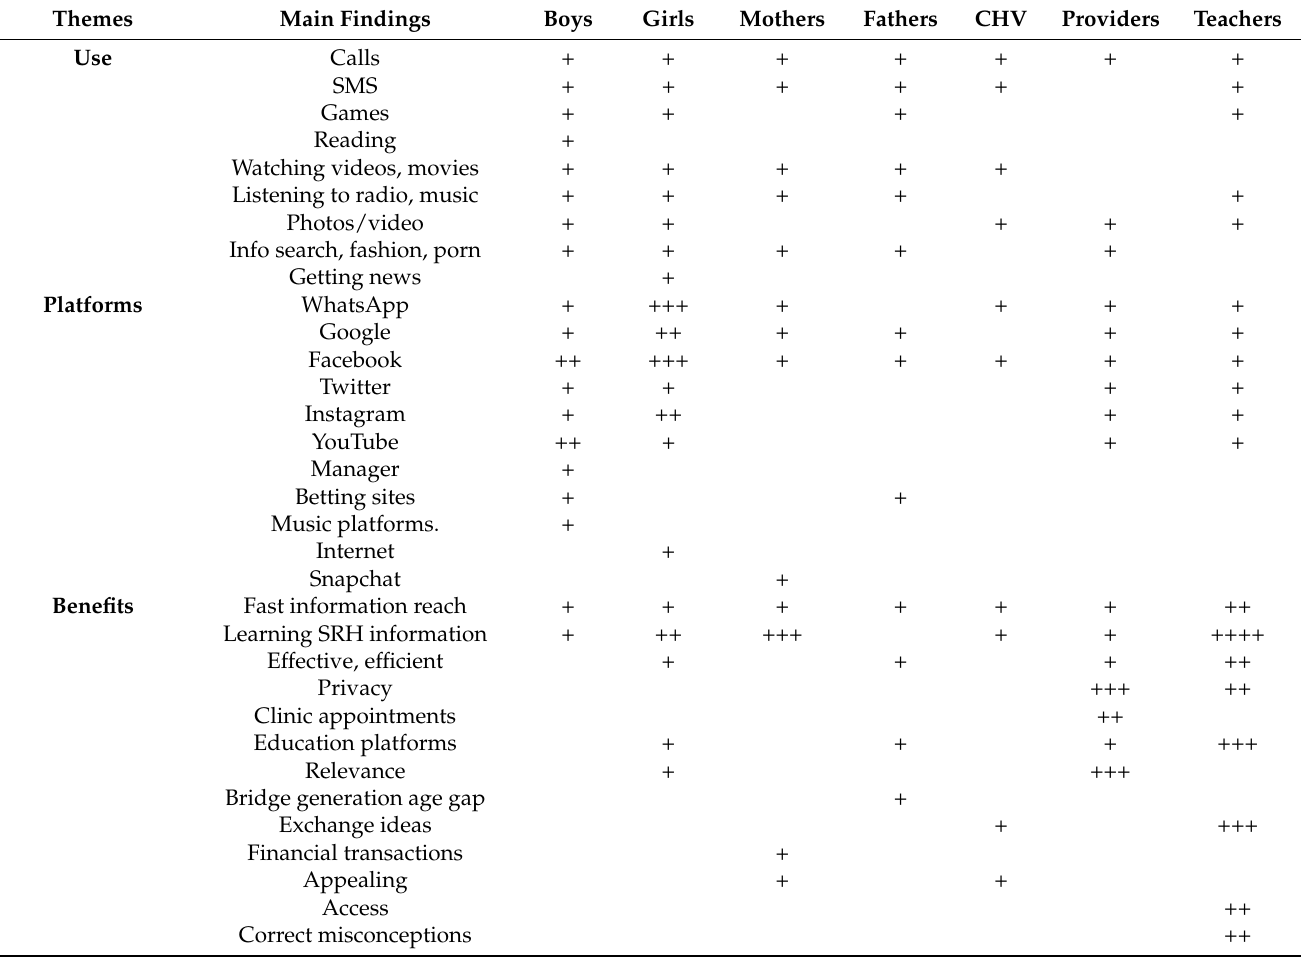
Table 1. Use of, preferred platforms, and benefits of mobile phones by respondent